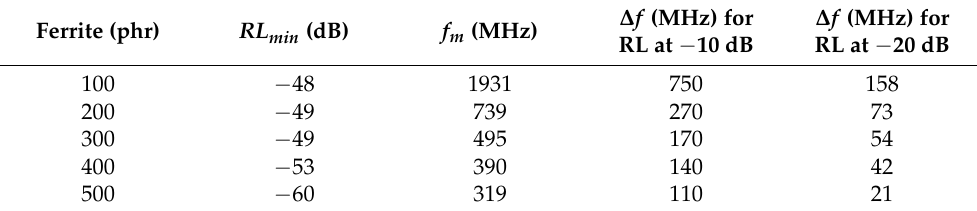
Figure 6. Frequency dependences of return loss for hybrid CB/ferrite filled composites. Table 3. Electromagnetic absorption characteristics of hybrid CB/ferrite filled